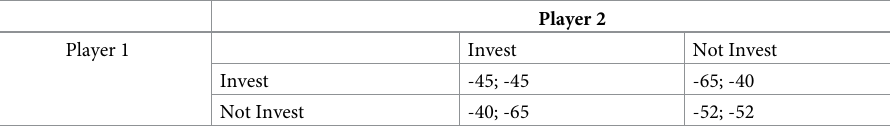
Table 3. Possible outcomes in the deterministic prisoner’s dilemma